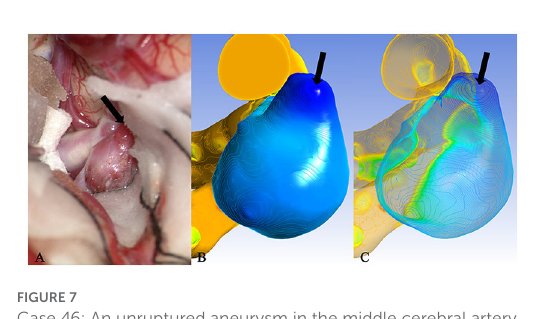
FIGURE7 Case 46: An unruptured aneurysm in the middle cerebral artery. The translucent area (black arrow) of the surface in (A) corresponded to the deeply stained area (black arrow) of the cloud map in (B) and the minimum extreme point in (C) . I δ of the minimum extreme point was between the optimal critical value of rupture and translucency. This was the most likely rupture